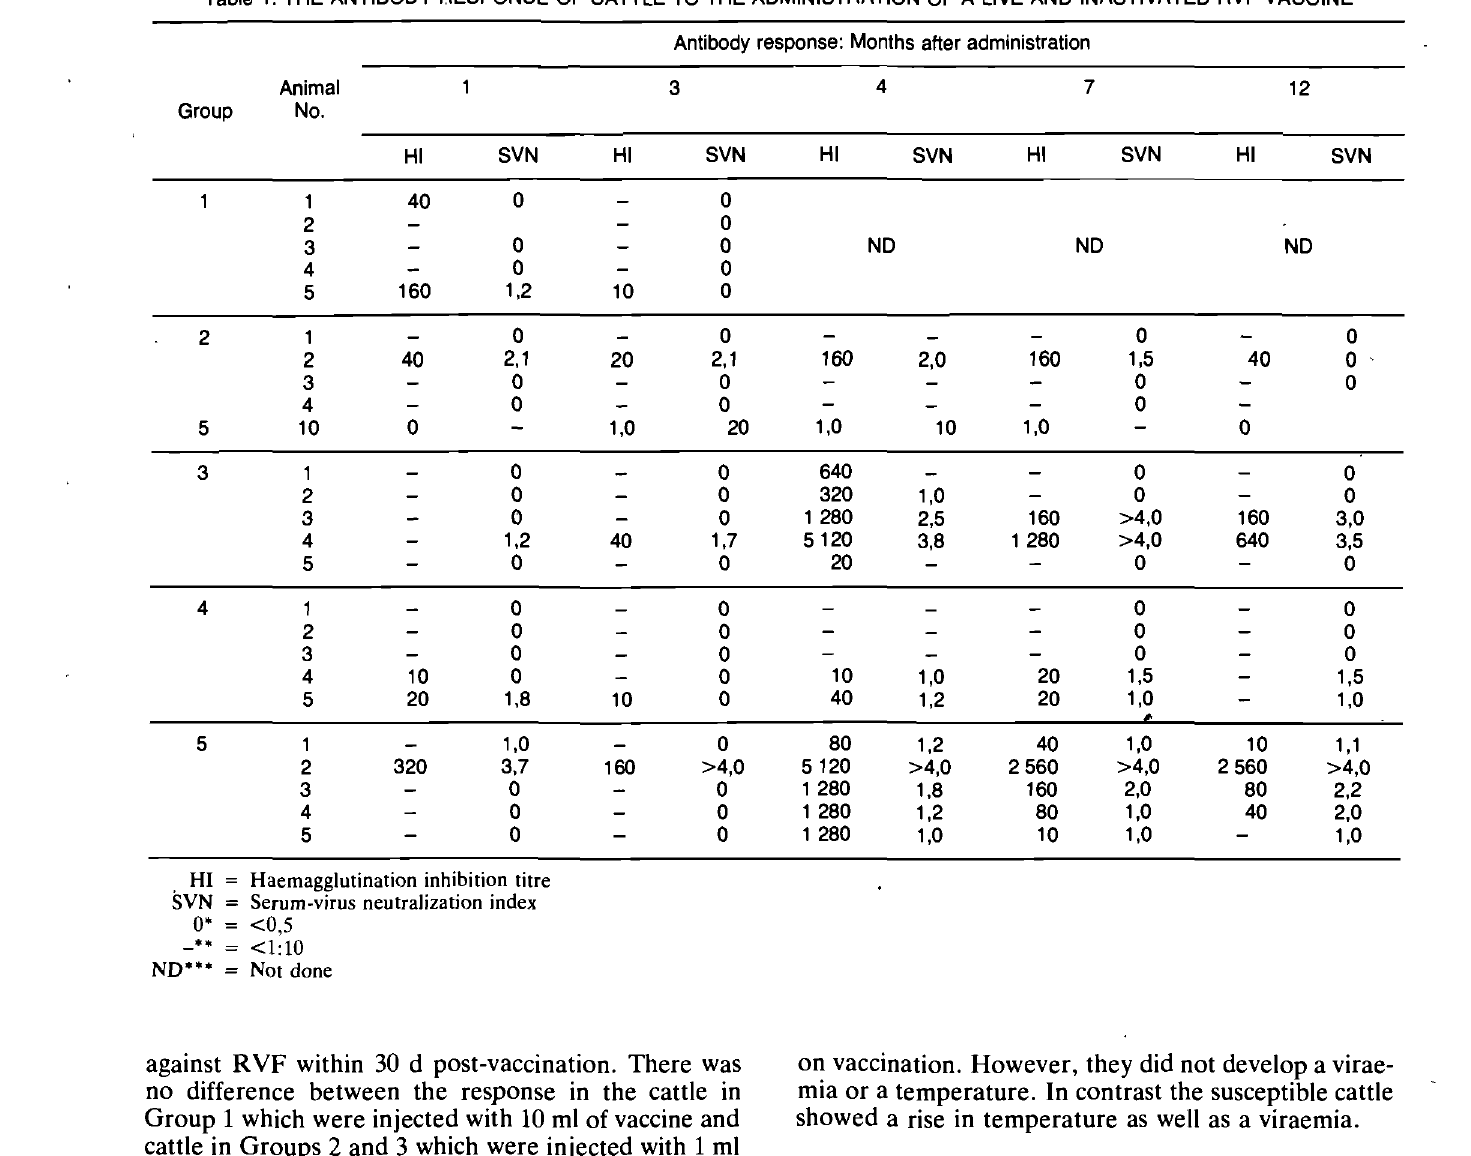
Table 1: THE ANTIBODY RESPONSE OF CATILE TO THE ADMINISTRATION OF A LIVE AND INACTIVATED RVF VACCINE Antibody response: Months after administration Animal